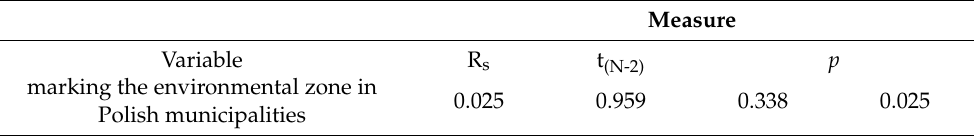
Table 4. Values of the R–Spearman correlation coefficients between the type of a municipality and the assessment of the importance of the environmental sphere in demarcating a brownfield in urban–rural municipalities.